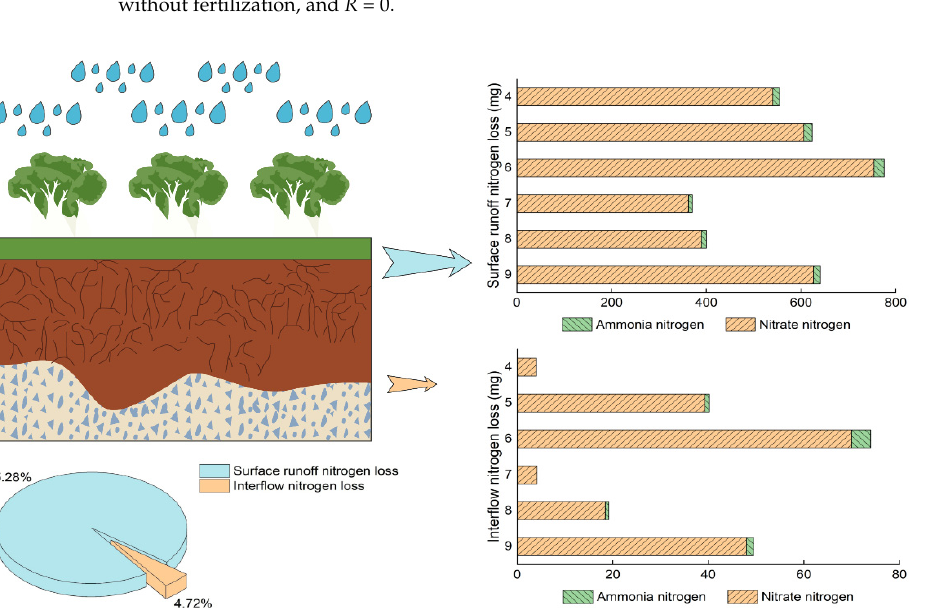
* In the control check (CK) group, L (Formula 2) represents the amount of nitrogen loss in the veg- etable field without fertilization, and R = 0.